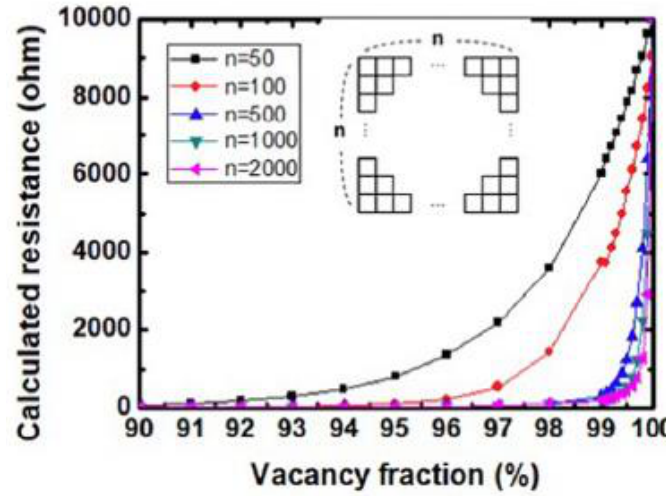
Figure 12. Calculated resistance changes of Ag NW networks as a function of vacancy fraction; Ag NW networks were modeled as a grid with a junction failure ratio of 1/8. Reproduced with permission from [49]. Copyright 2019 Elsevier.